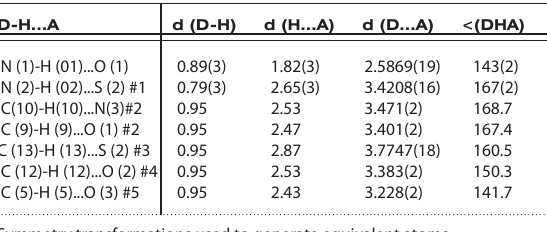
Table 1. Hydrogen bonds [Å and °] for compound 1a D-H...A d (D-H) N (1)-H (01)...O (1)